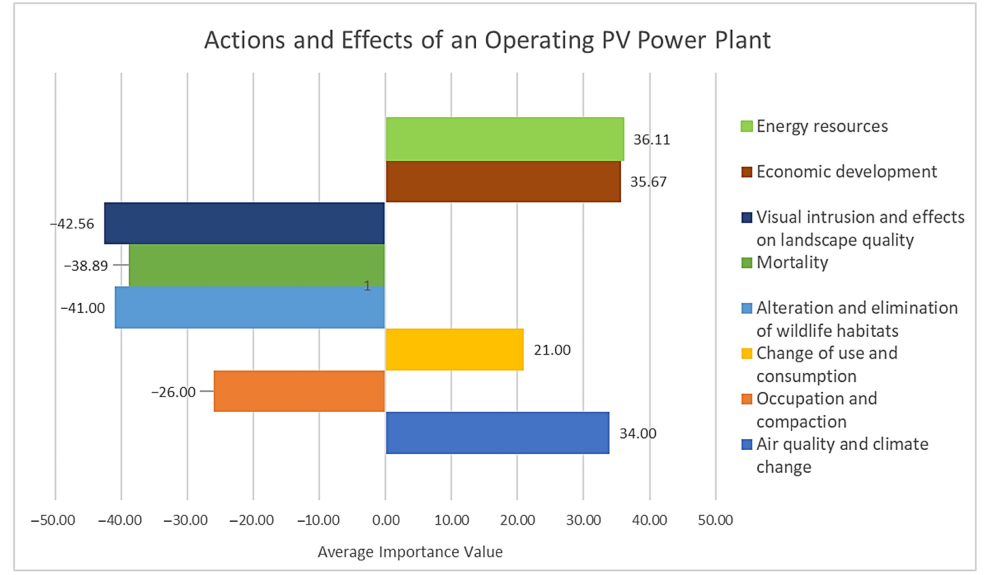
Figure 10. Average importance values of the actions regarding the operational phase of PV